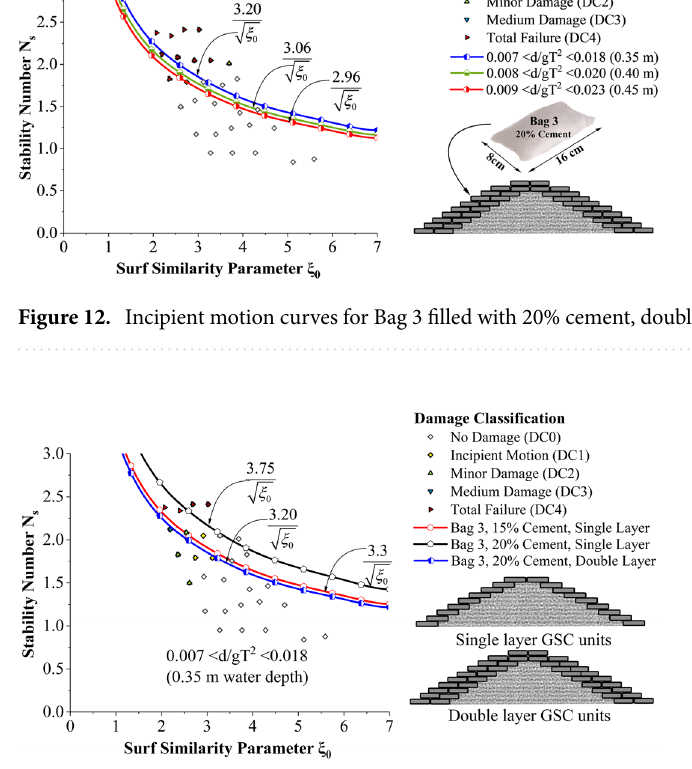
Figure 13. Stability curves of all experimented configurations for a relative water depth 0.007 < d/gT 2 < 0.018 (0.35 m actual water depth in